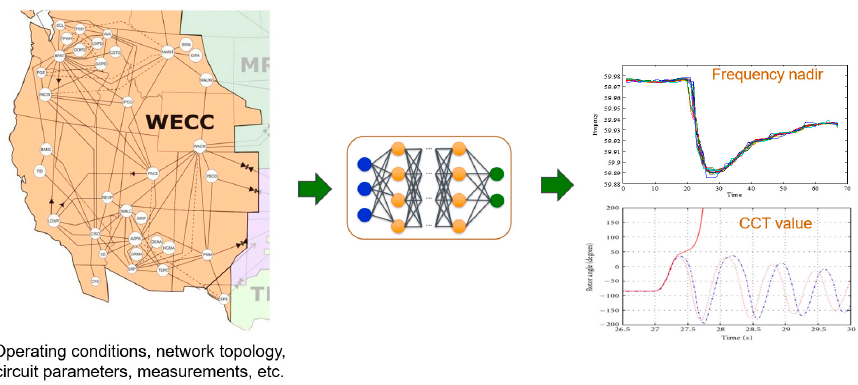
Figure 1. Illustration of the proposed AI-based stability assessment method.